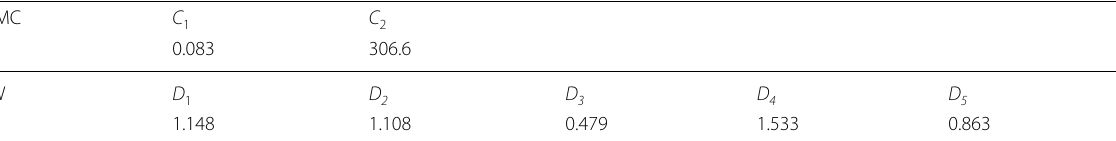
Table 4 Material constants of ductile fracture criterion